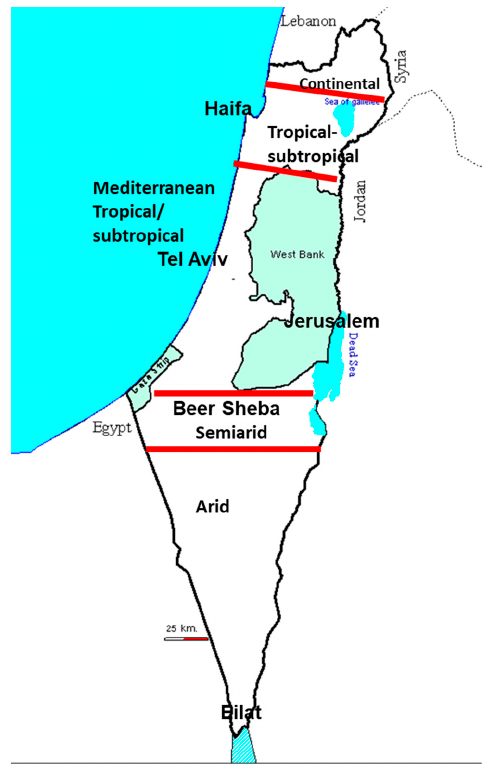
Figure 1. Schematic demonstration of the various climatic zones in Israel.